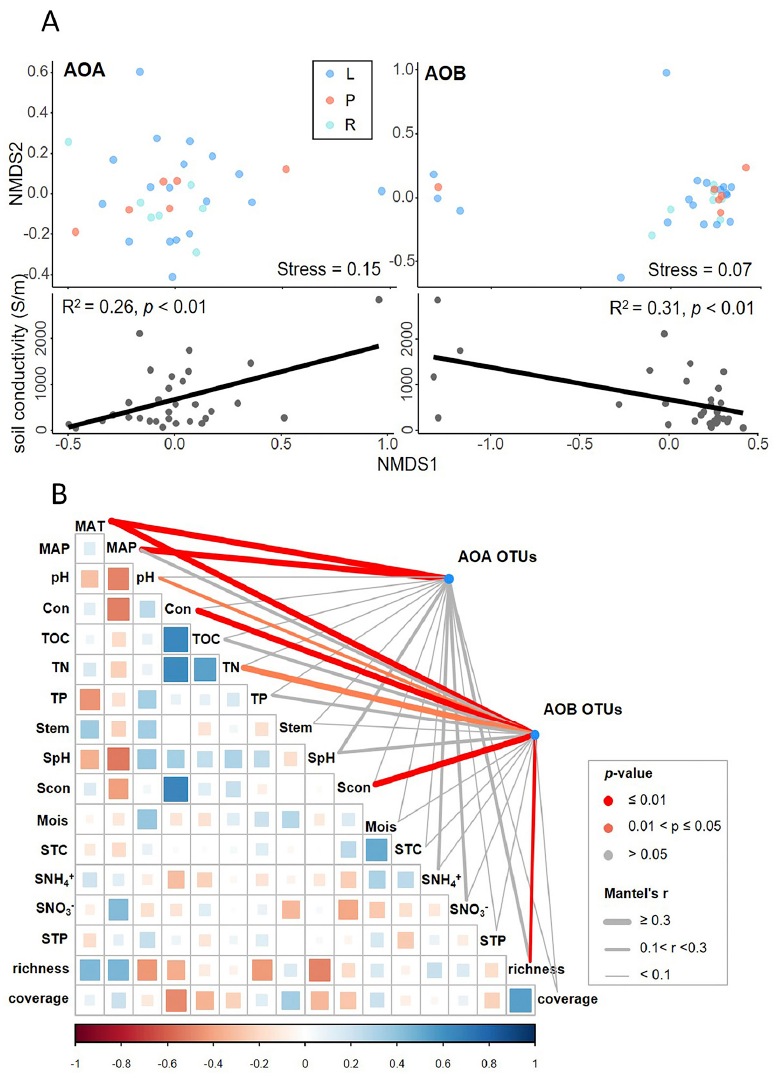
Figure 7. Environmental drivers of ammonia-oxidizing microbe community compositions. ( A ) Non-metric multidimensional scaling (NMDS) ordination based on unweighted Unifrac distances similarity shows that ammonia-oxidizing microbe community composition are not grouped clearly by wetland types (top), but rather separated by the local soil conductivities as shown by the significant correlations (bottom). ( B ) Pairwise comparisons of environmental factors are shown, with a color gradient denoting Spearman’s rank correlation coefficient. Ammonia-oxidizing archaea (AOA) and ammonia-oxidizing bacteria (AOB) community composition (Bray-Curtis distance) was related to each environmental factor by partial (geographic distance corrected) Mantel test. Edge width denotes the Mantel’s r statistic and the edge color corresponds to the statistical significance based on 9,999 permutations. MAT: mean annual temperature; MAP: mean annual precipitation; Con: conductivity in water; TOC: total organic carbon in water; TN: total nitrogen in water; TP: total phosphorous in water; Stem: soil temperature; SpH: soil pH; Scon: conductivity in soil; Mois: soil moisture; STC: total carbon in soil; SNH 4 + : soil NH 4 + -N; SNO 3 − : soil NO 3 − -N; STP: total phosphorous in soil; richness: plant species richness; coverage: plant